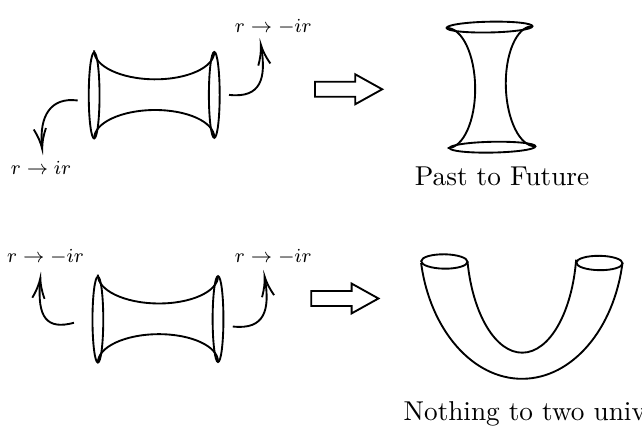
Figure 4 . AdS to dS double trumpet analytic